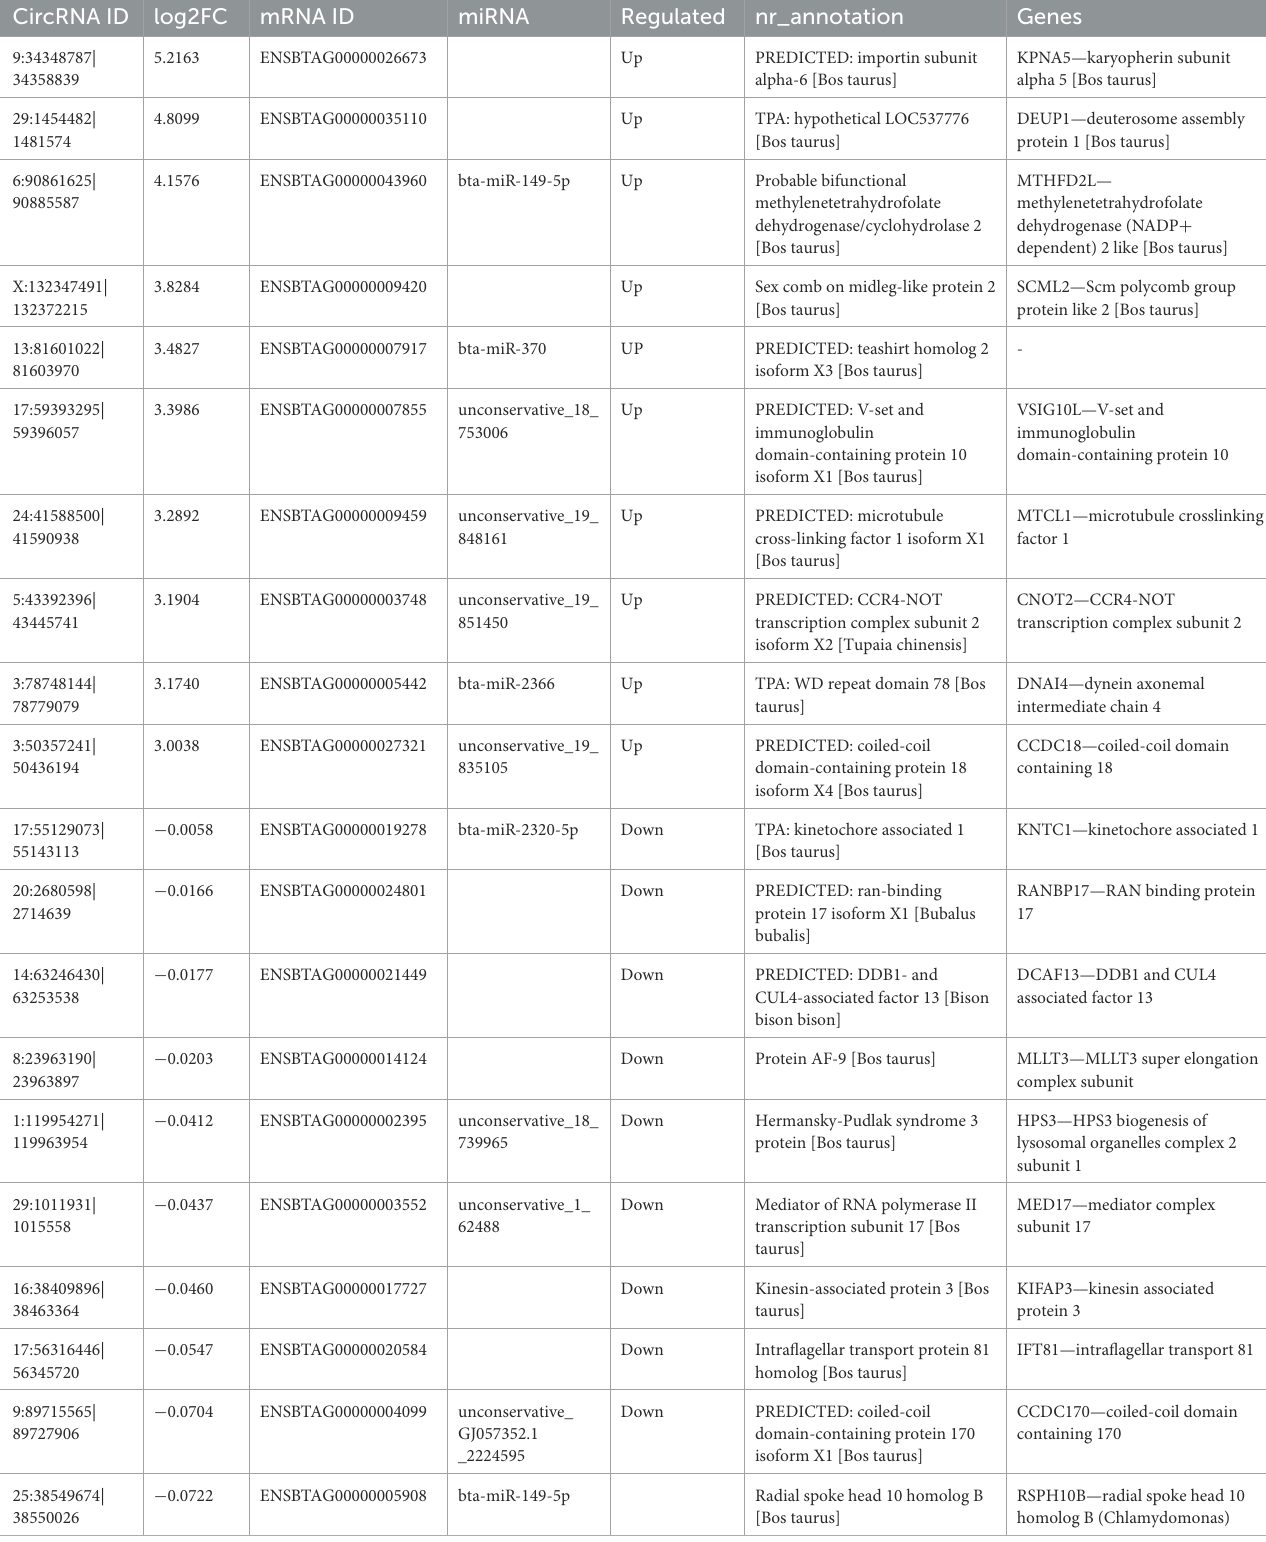
TABLE 8 TOP20 with significantly differentially expressed